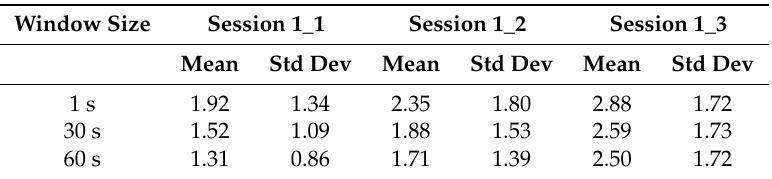
Table 1. Localization error for single-participant sessions, using motion-sensor and Bluetooth Low-Energy (BLE)-Estimote data. All the measurements are in meters.